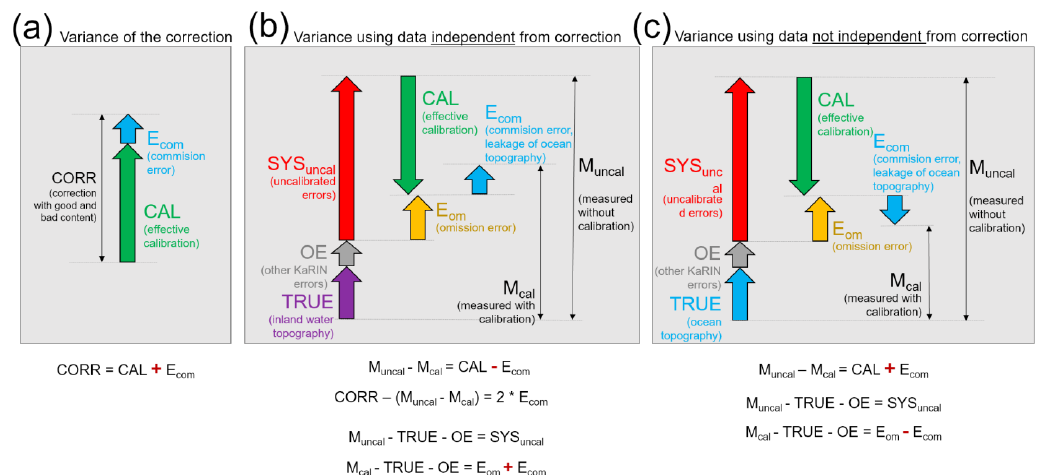
Figure 22. Schematics of the variance contributors. Panel ( a ) shows the variance of the correction. Panel ( b ) shows the contributors of measurable variance terms when the validation data is inde- pendent from the correction (i.e., inland data for our context). Panel ( c ) is the same when the vali- dation data is not independent and positively correlated with the correction (i.e., leakage of ocean variability in the correction).